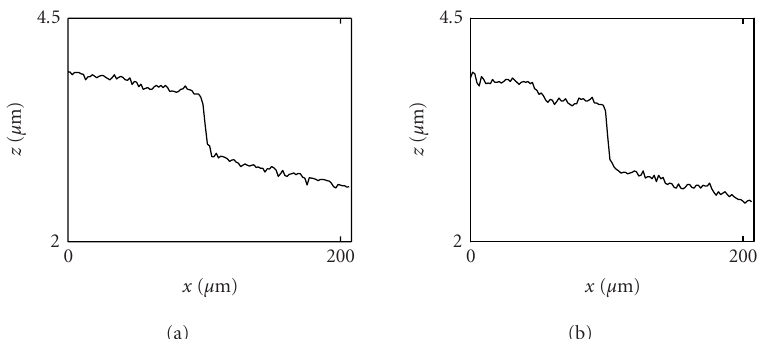
For the higher-order functions, the spline technique is com- petitive in the presence of noise and should o ff er more flex- ibility for a nonsymmetrical envelope. A general rule re- lating the order, the lag parameter, and the sampling step is introduced. For a given sampling period, there exists an optimal choice of these energetic operators which leads to flexible operators in terms of sampling step, precision, and noise level. This flexibility is important for choosing the op- timal algorithm for a given sample and measurement condi-